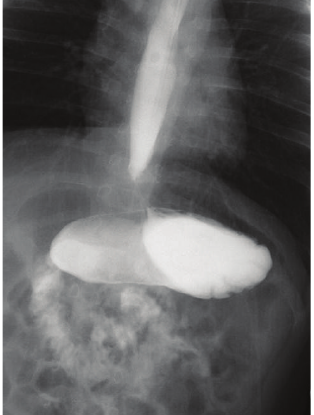
Figure 2: Organoaxial gastric volvulus. The stomach is oriented with the organoaxial (longitudinal) axis which extends from the gastroesophageal junction to the pylorus, thus giving an “upside- down”